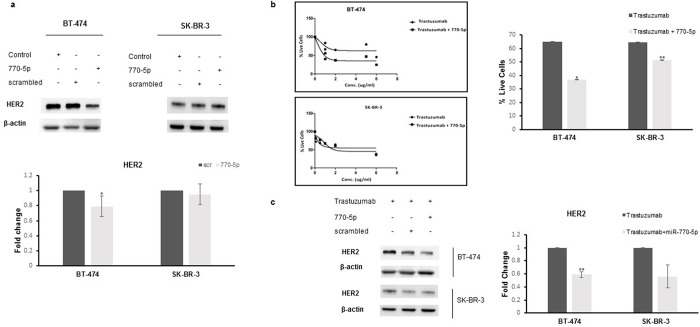
miR-770-5p overexpression downregulated HER2 and increased the effect of trastuzumab.(a) The protein expression level of HER2 was slightly diminished in both cell lines following miR-770-5p transfection n = 3, p<0.05). (b) Combinational treatment of cells with trastuzumab and miR-770-5p decreased cell viability in BT-474 and SK-BR-3 cells (n = 3, *p<0.001, **p<0.05); HER2 expression also reduced significantly, especially in BT-474 cells (c) (**p<0.05).